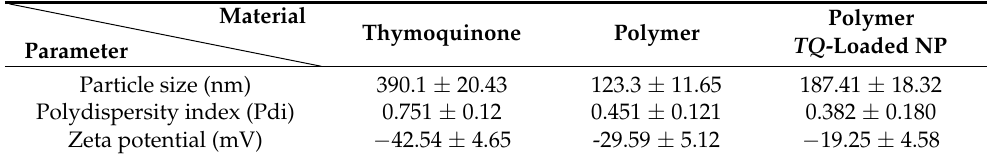
Table 3. Particle size parameters of TQ, the polymer, and TQ–polymer-loaded nanoparticles (means ± SD, n = 3).